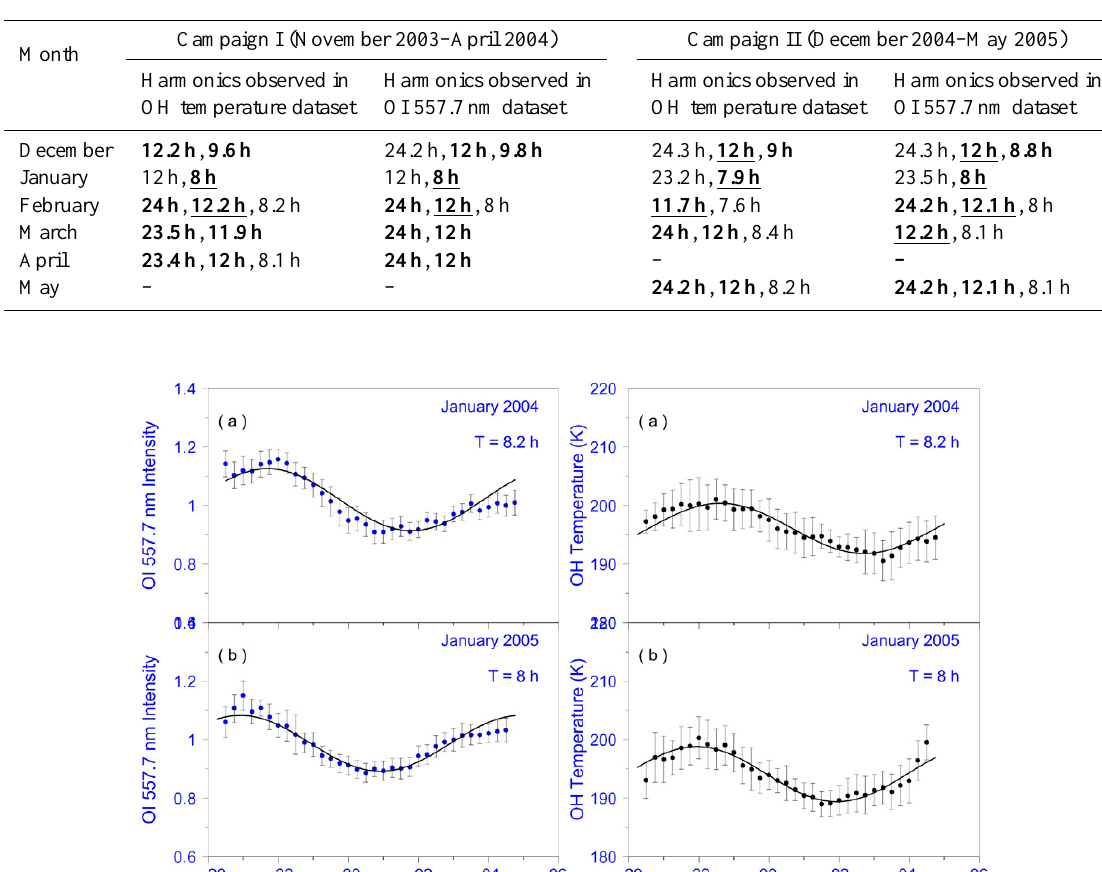
Table 2. Results of Lomb-Scargle analysis for tide-like oscillations ∼ monthly characterization.